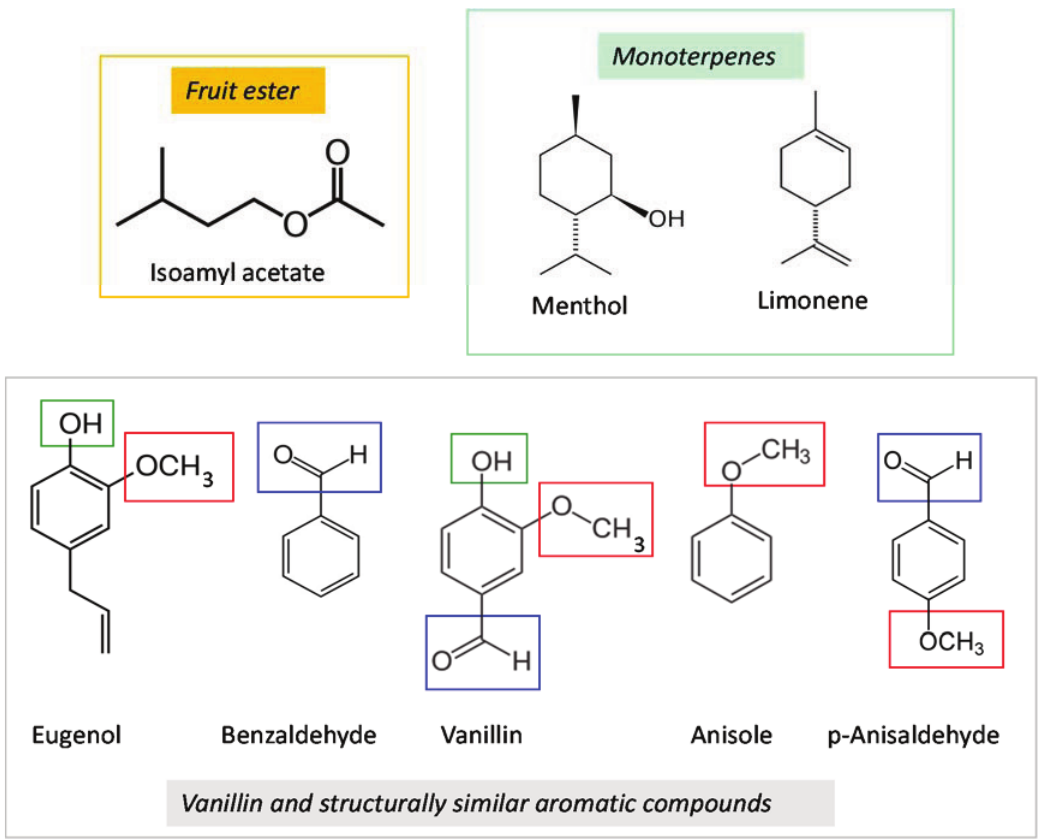
Figure 1. Chemical classes of test